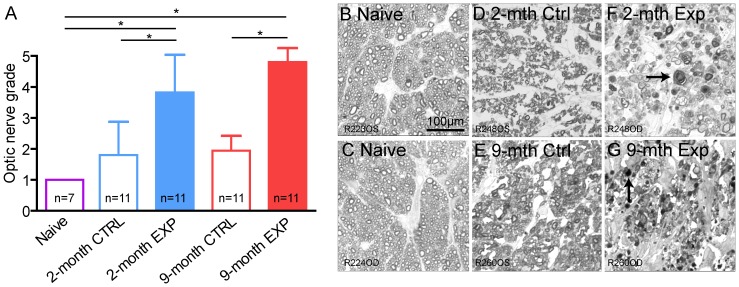
Optic nerve grading.Optic nerve axon damage was assessed by masked, semi-quantitative grading [54], [55] of sections obtained 1 mm from the globe. (A) Results of optic nerve axon grading. (B-G) Representative examples of optic nerve cross-sections at 3-weeks stained with p-phenylenediamine. (B, C). Naïve normal (grade 1). (D) 2-month fellow control (grade 1.5). (E) 9-month fellow control (grade 1.5). (F) 2-month experimental (grade 4). (G) 9-month experimental (grade 5). Arrows point to unraveled myelin seen only in experimental nerves. Both experimental age-groups show severe axon damage relative to fellow control and naïve nerves. Fellow control nerves also show some focal degeneration/swelling relative to the naïve nerves but no unraveling of myelin. Error bars  =  SEM. * indicates p<0.05 (Dunn's post-hoc test). Abbreviations: EXP  =  experimental eyes, CTRL  =  fellow control eyes.